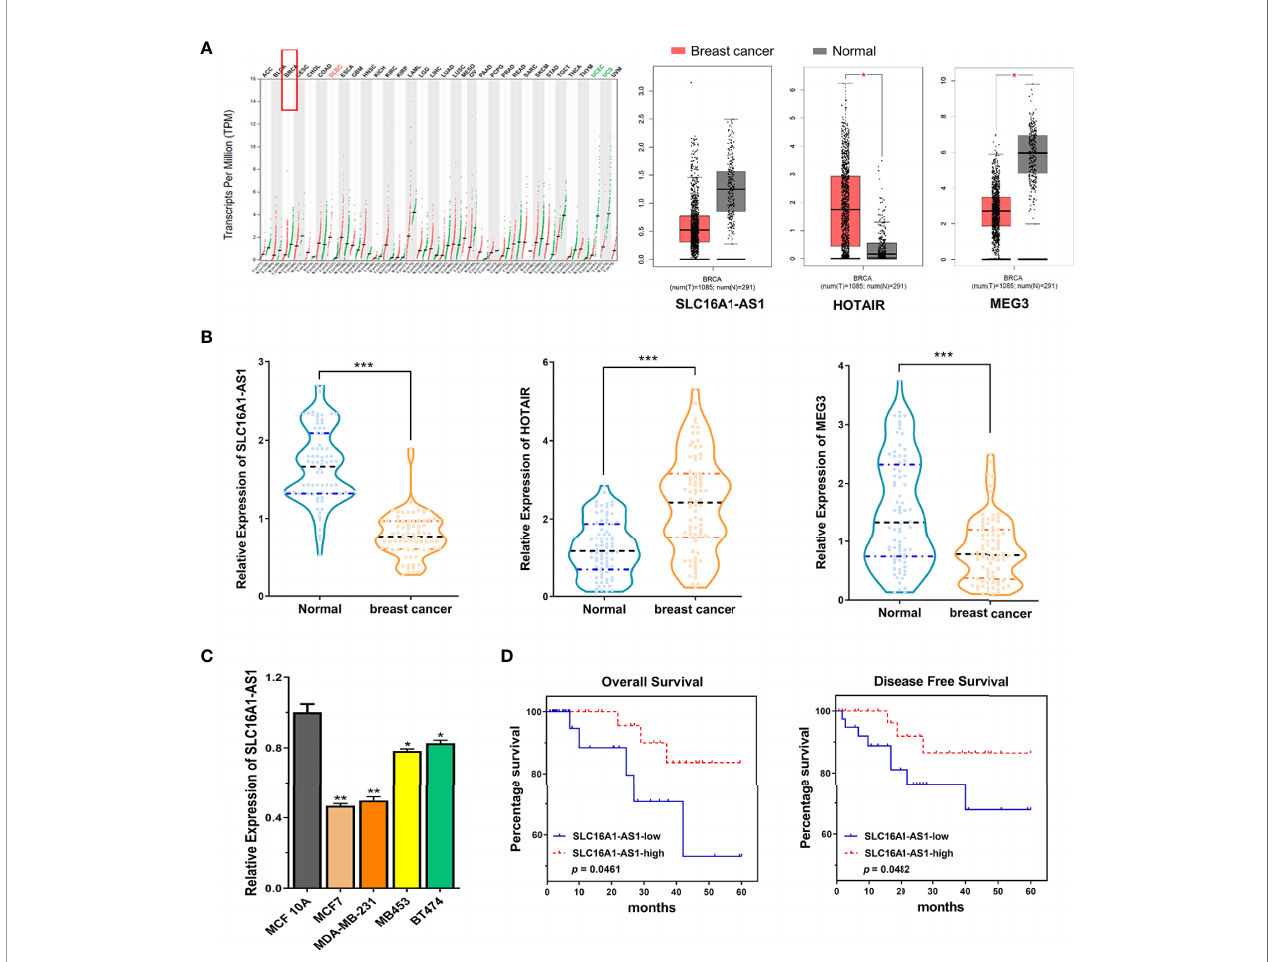
FIGURE 1 | Expression of SLC16A1-AS1 is signi fi cantly downregulated in breast cancer (BC) cells and tissues and related to the prognosis of BC patients. (A) Bioinformatics analysis found downregulated SLC16A1-AS1 and MEG3 but upregulated HOTAIR expressions in tumor (T) tissues versus normal (N) tissues of BC (BRCA) patients by investigating the TCGA datasets using the online tool GEPIA. (B) SLC16A1-AS1 and MEG3 expressions were meaningfully downregulated, while HOTAIR expression was meaningfully upregulated in BC tissues versus paracancerous tissues from 80 BC patients analyzed by the qRT-PCR assay. (C) SLC16A1- AS1 expression was meaningfully lower in human BC (MCF7, MDA-MB-231, MB453, and BT474) than in human normal mammary gland epithelial cells (MCF 10A) analyzed with qRT-PCR, and the difference was most signi fi cant in MCF7 and MDA-MB-231 cells. (D, E) Analyzed by the Kaplan – Meier method among the 80 BC patients, lower SLC16A1-AS1 expression indicated a poor prognosis both in overall survival (D) and disease-free survival (E) . * p < 0.05, ** p < 0.01, *** p <